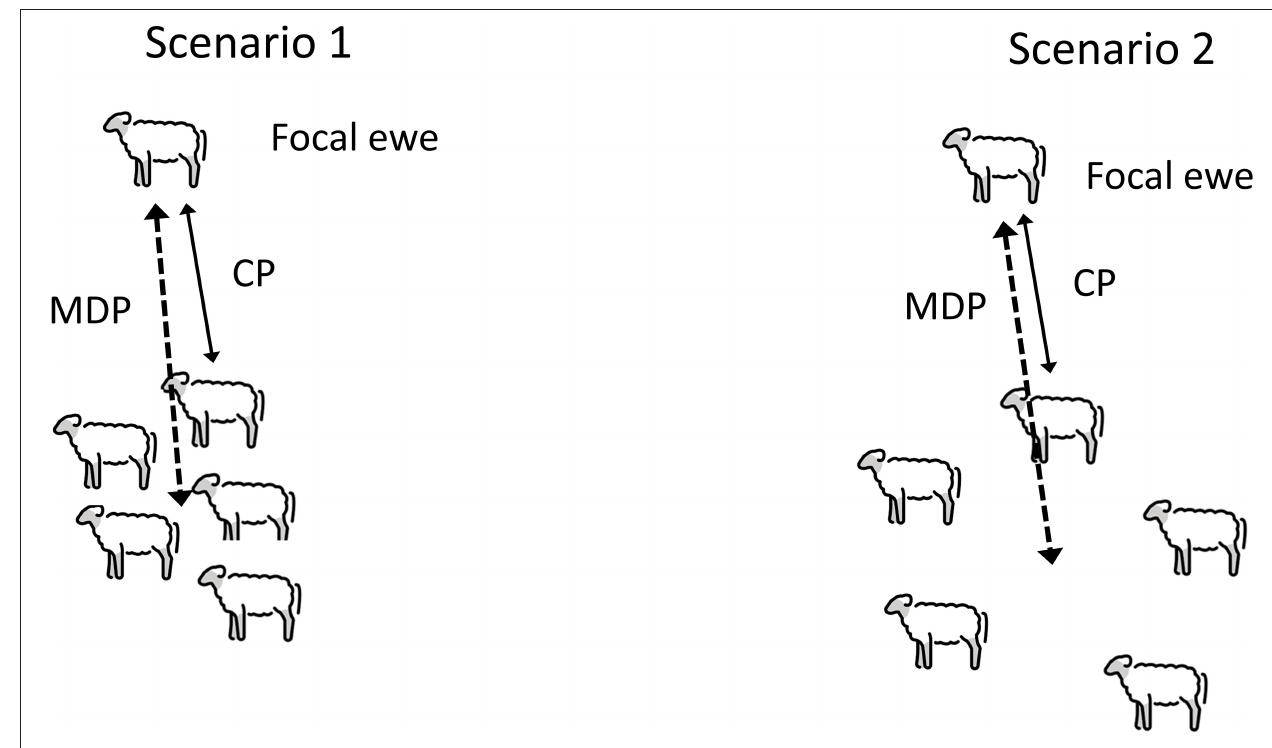
FIGURE 2 | Example of the informative value of considering both the mean distance to peers for the focal ewe (MDP, dashed line) and the average distance from peers of the entire flock. Distance to the closest peer (CP) is one of the important factors for detecting parturition ( Fogarty et al., 2021). When the ewe separates from the herd both CP and MDP increase, which is often associated with lambing. However, the signal from MDP and CP is more meaningful in Scenario 1 when the average distance to peers of the entire flock) is relatively low. In contrast, the average distance to peers of the entire flock is larger in Scenario 2 which makes the larger MDP and CP less useful for detecting if the focal ewe is